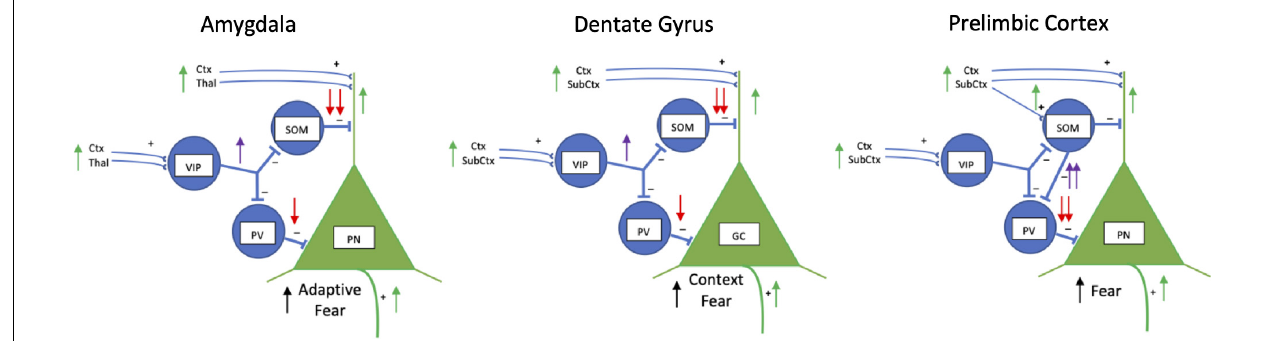
FIGURE 2 | Schematic drawings of inhibitory interneuron regulation of fear in basolateral amygdala, dentate gyrus, and prelimbic cortex. Vasoactive intestinal peptide (VIP), somatostatin (SOM) and parvalbumin-expressing (PV) inhibitory interneurons work together to regulate activity of excitatory pyramidal neurons (PN) in the basolateral amygdala and prelimbic cortex, and granule cells (GC) in the hippocampus. Normally, PNs are strongly inhibited by SOM and PV neurons and fire infrequently (not shown). During fear, in the amygdala and dentate gyrus VIP interneurons (purple arrow) inhibit SOM and PV interneurons (red arrows) which disinhibit PNs (green arrows) activated by conditioned and aversive stimuli signals. In the amygdala and dentate gyrus during fear conditioning, VIP neurons are activated by aversive stimuli (i.e., footshock) through cortical (Ctx), thalamic (Thal) and other subcortical (SubCtx) inputs to strongly inhibit somatostatinergic neurons (SOM) and less strongly inhibit parvalbumin-containing interneurons (PV). Inhibition of SOM interneurons disinhibits dendrites of excitatory PNs and GCs activated during fear. During fear recall, a fear conditioned stimulus alone stimulates VIP interneurons to disinhibit dendrites of PNs and GCs through inhibition of SOM interneurons. In the prelimbic cortex, VIP inhibition appears to play less of a regulatory role. During fear conditioning and recall, SOM interneurons are activated and weakly inhibit PN dendrites, but strongly inhibit PV interneurons (purple arrows) which disinhibit the soma of PNs (red arrows) to facilitate firing of PNs. Disinhibited PNs project to other areas to initiate fear responses. Not shown for simplicity is SOM lateral inhibition of dendrites of nearby PNs. Lateral inhibition limits the number of PNs participating in the fear engram. Also, not shown is reciprocal inhibition between VIP, SOM, and PV